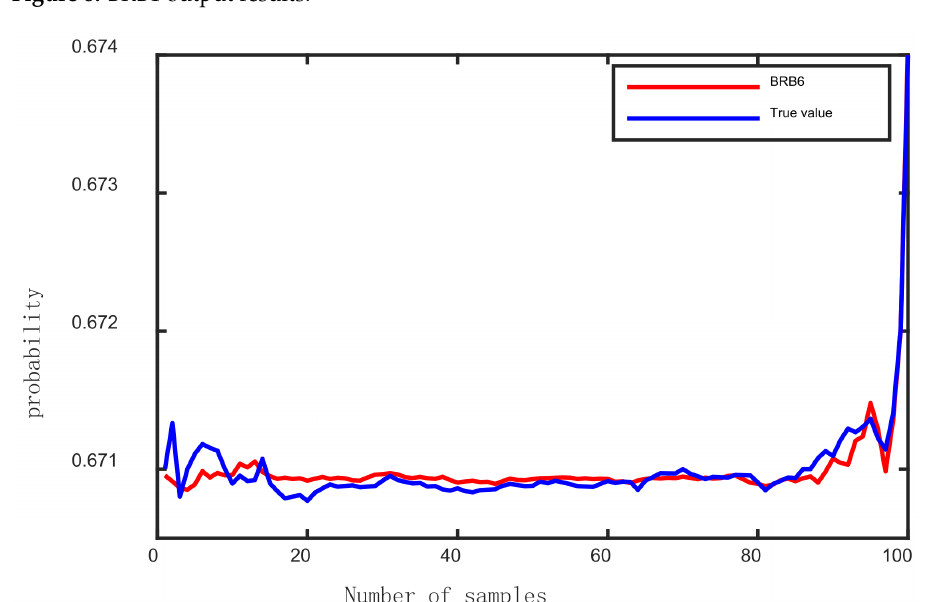
Figure 9. BRB6 output